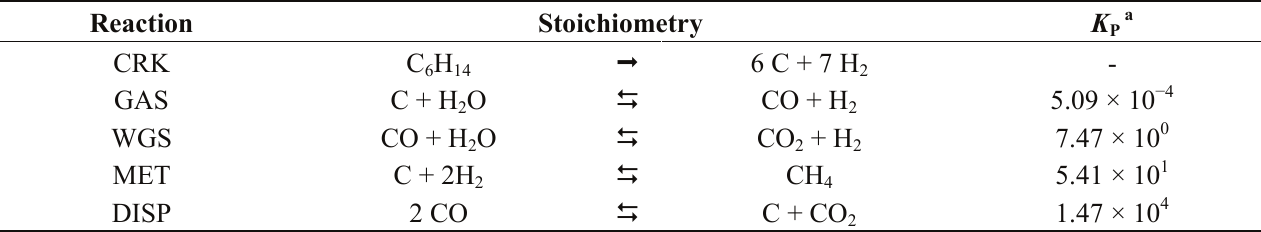
Equilibrium pressure constant values at 450 °C with P x values in